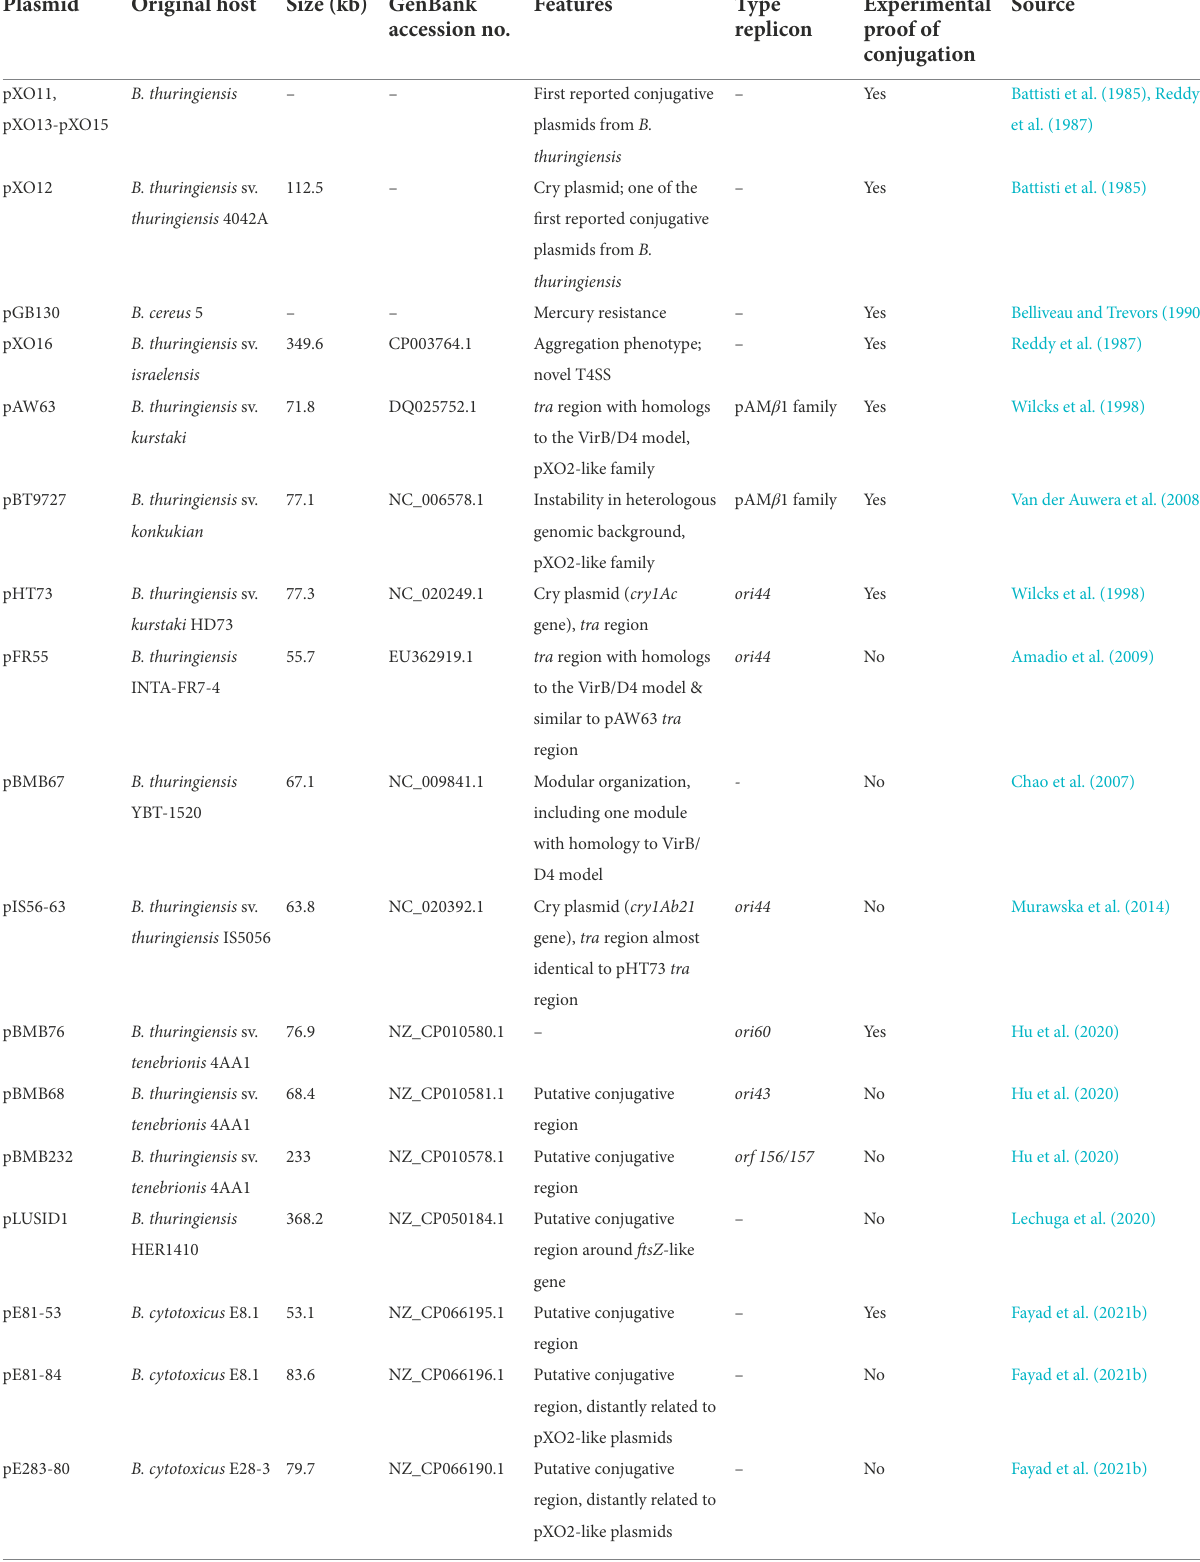
TABLE 1 Conjugative plasmids from B. cereus s.l. List of B. cereus s.l. plasmids reported as conjugative – or potentially conjugative – and their main characteristics. Plasmid Original host Size (kb) GenBank accession no.